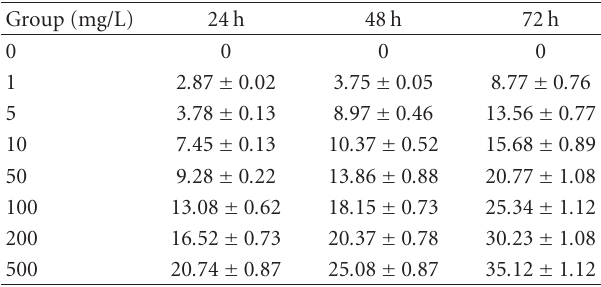
Table 2: E ff ects of endostar on growth inhibition rate of A549 cells under hypoxia